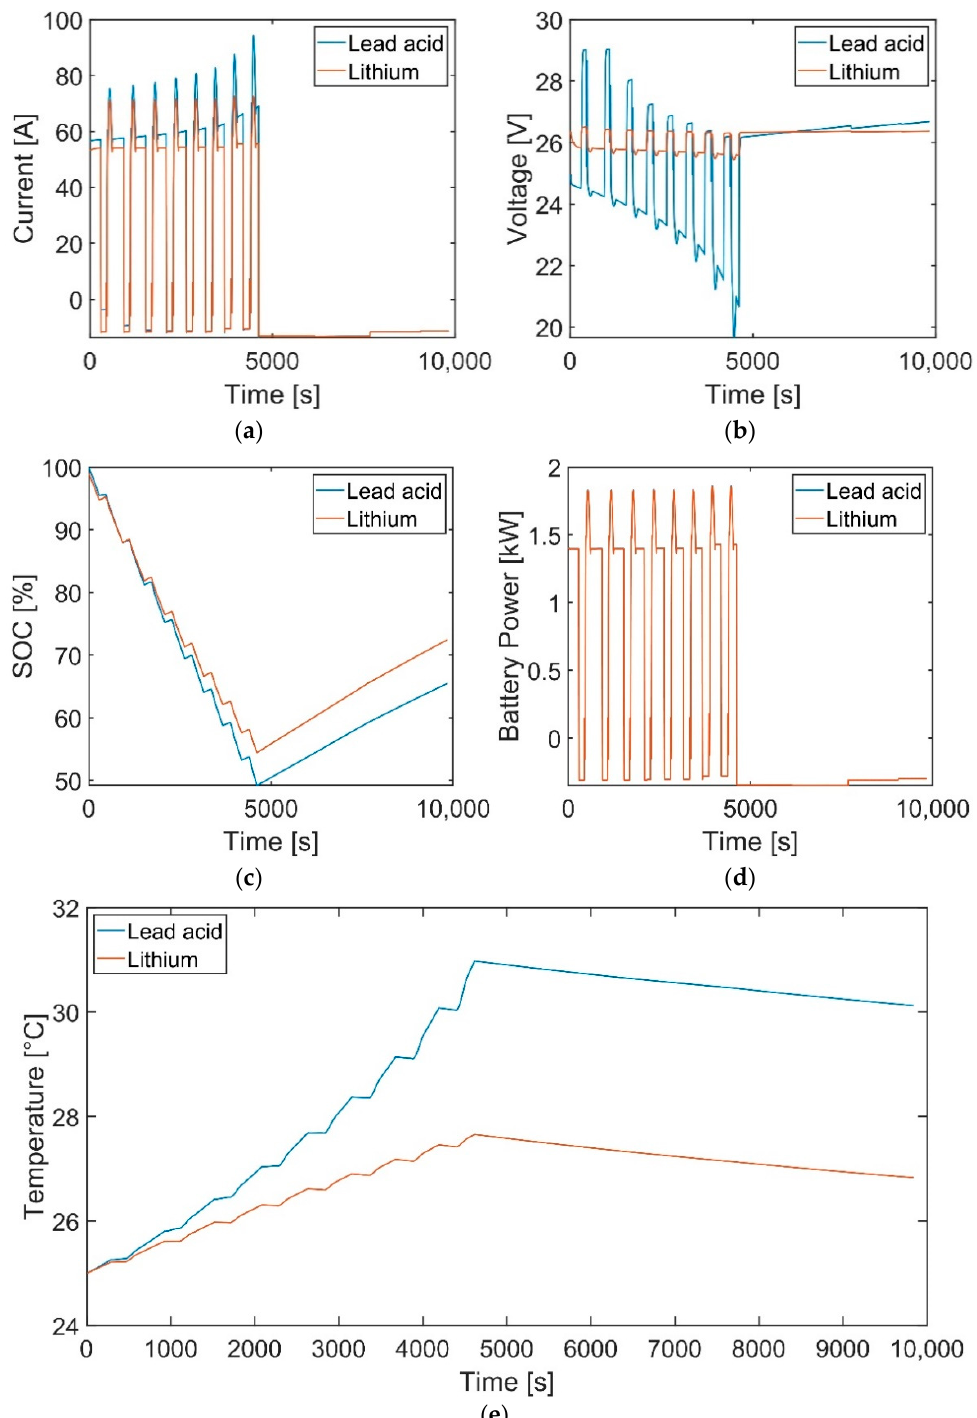
Figure 6. Comparison of electrical and thermal behavior between lead-acid and lithium batteries: ( a ) Current, ( b ) voltage, ( c ) SOC, ( d ) power, and ( e ) temperature.